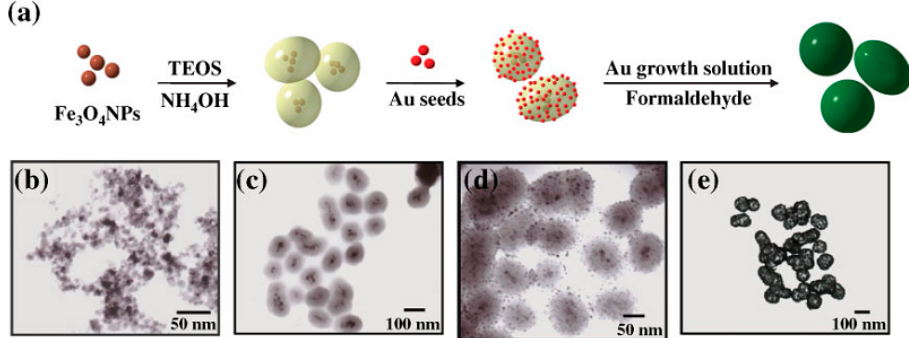
Figure 4. ( a ) Schematic representation of the preparation of Fe 3 O 4 -Au nanoeggs. TEM images of the ( b ) magnetic iron oxide NPs; ( c ) silica nanoeggs embedding magnetic iron oxide NPs (Fe 3 O 4 -SiO 2 ); ( d ) gold nanoseeds bound to Fe 3 O 4 -SiO 2 NPs (Fe 3 O 4 -SiO 2 -Au); and ( e ) Fe 3 O 4 -Au nanoeggs. Reproduced with permission from [49]. John Wiley and Sons, 2009.